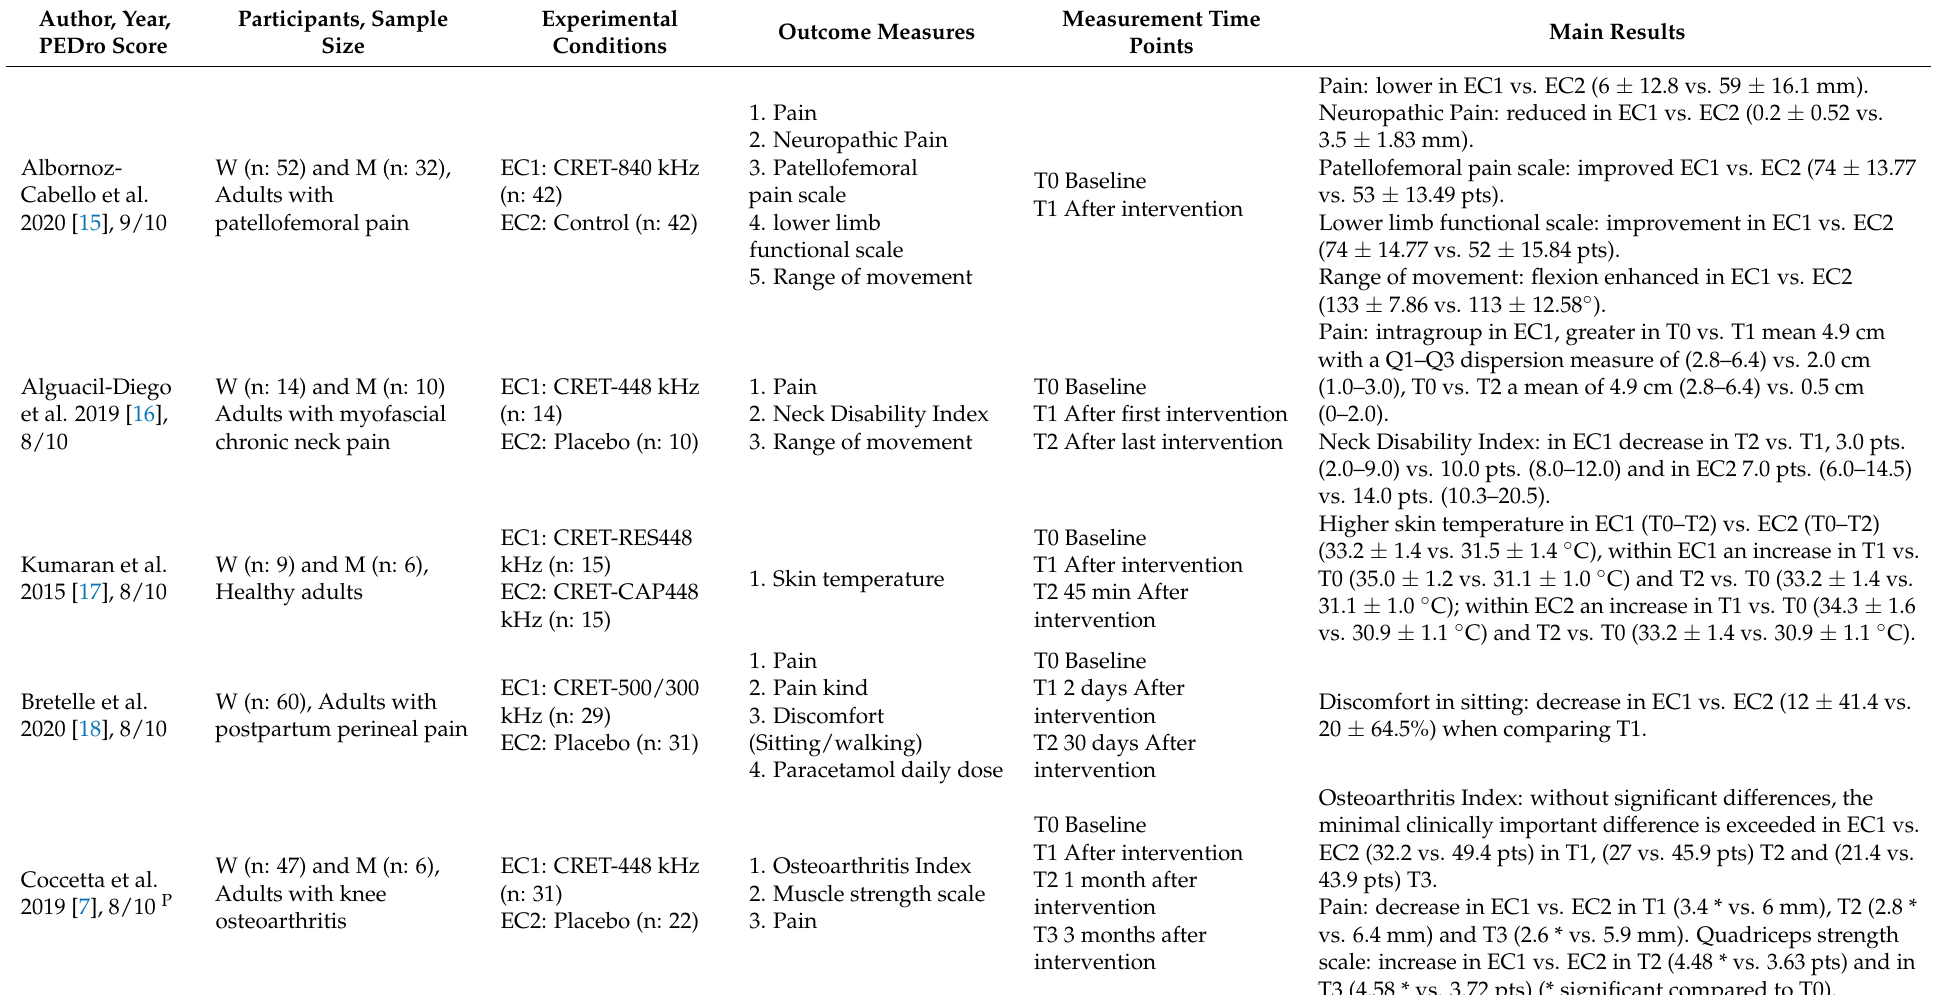
Table 2. Summary of relevant findings for the 30 included